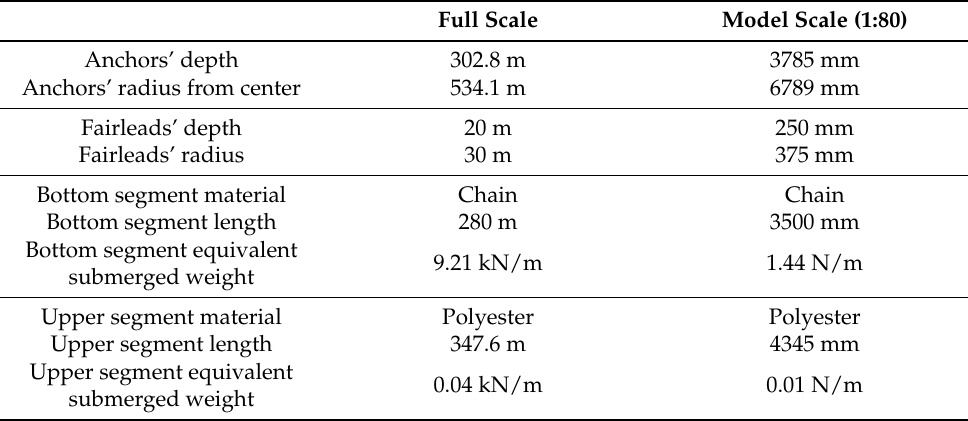
Table 2. Jappaku FOWT mooring system main properties.